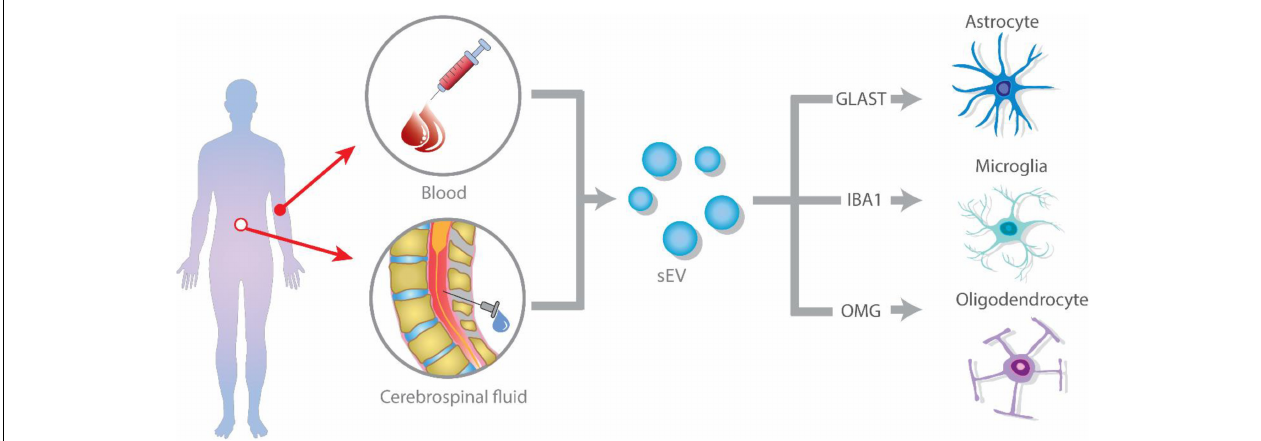
FIGURE 1 | Glial-derived exosomes isolation strategies from blood or plasma. Extracellular vesicles (EVs) are released by glial cells, containing different cargo molecules such as cytokines, proteins, and non-coding RNA. The ability of EVs to cross the blood–brain barrier (BBB), allows them to enter the peripheral blood and cerebrospinal fluid (CSF). Isolation of glial cell-derived exosomes from blood or CSF is accomplished by identifying glial-specific proteins surface markers, such as glutamate aspartate transporter (GLAST) for astrocytes, CD11b and isolectin B4 (IB4) for microglia, and oligodendrocyte-myelin glycoprotein (OMG) for oligodendrocytes.